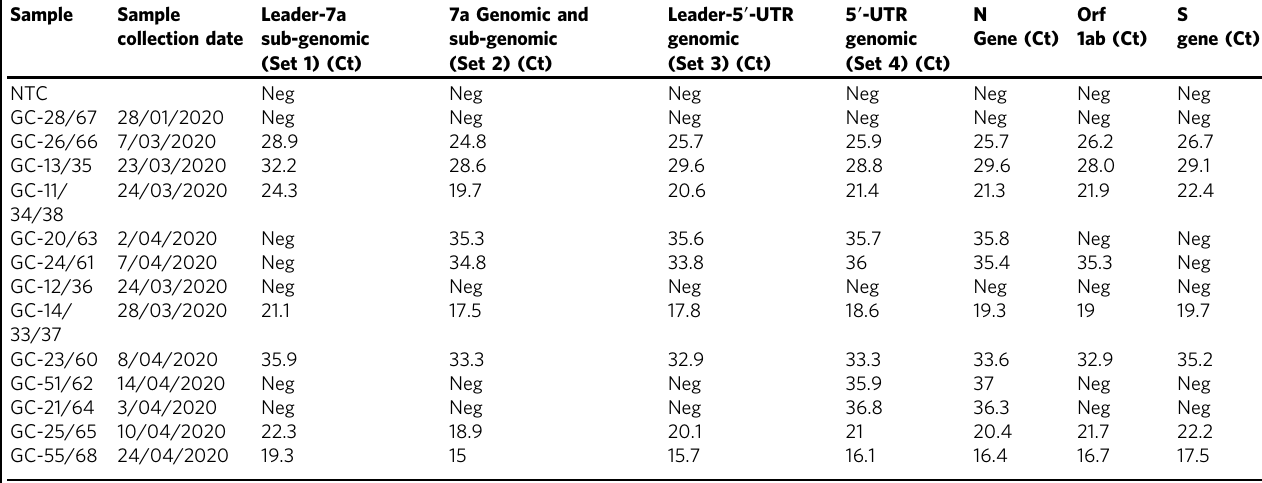
Table 5 Table showing sample details with corresponding Ct values of PCR ampli fi cation using speci fi c targets. Sample Sample Leader-7a collection date sub-genomic